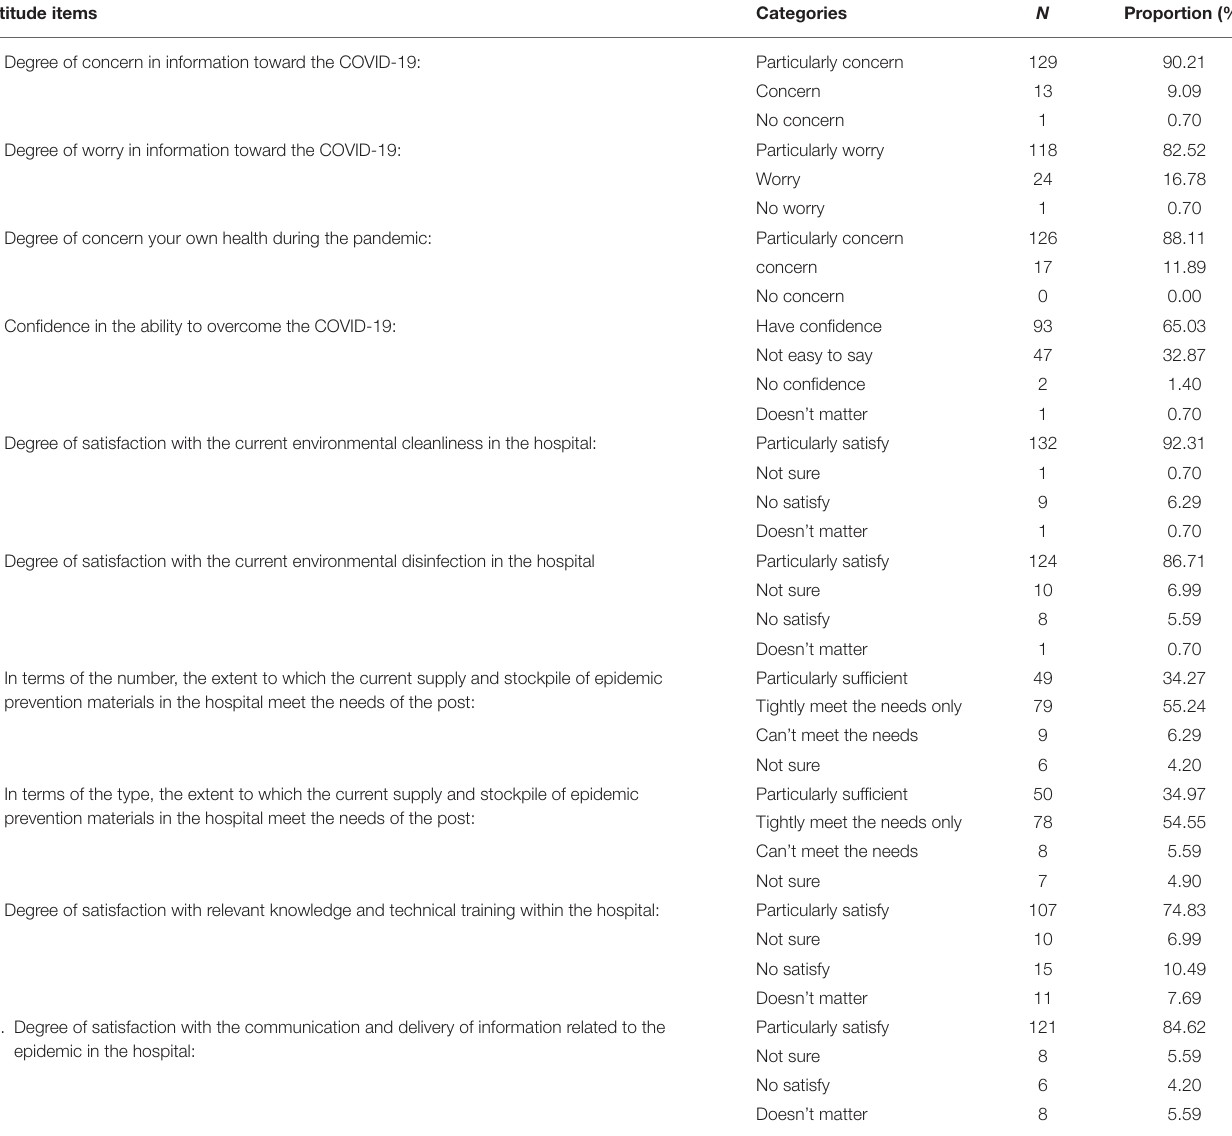
TABLE 2 | Responses of the participants to the attitude items on the questionnaire ( n = 143). Attitude